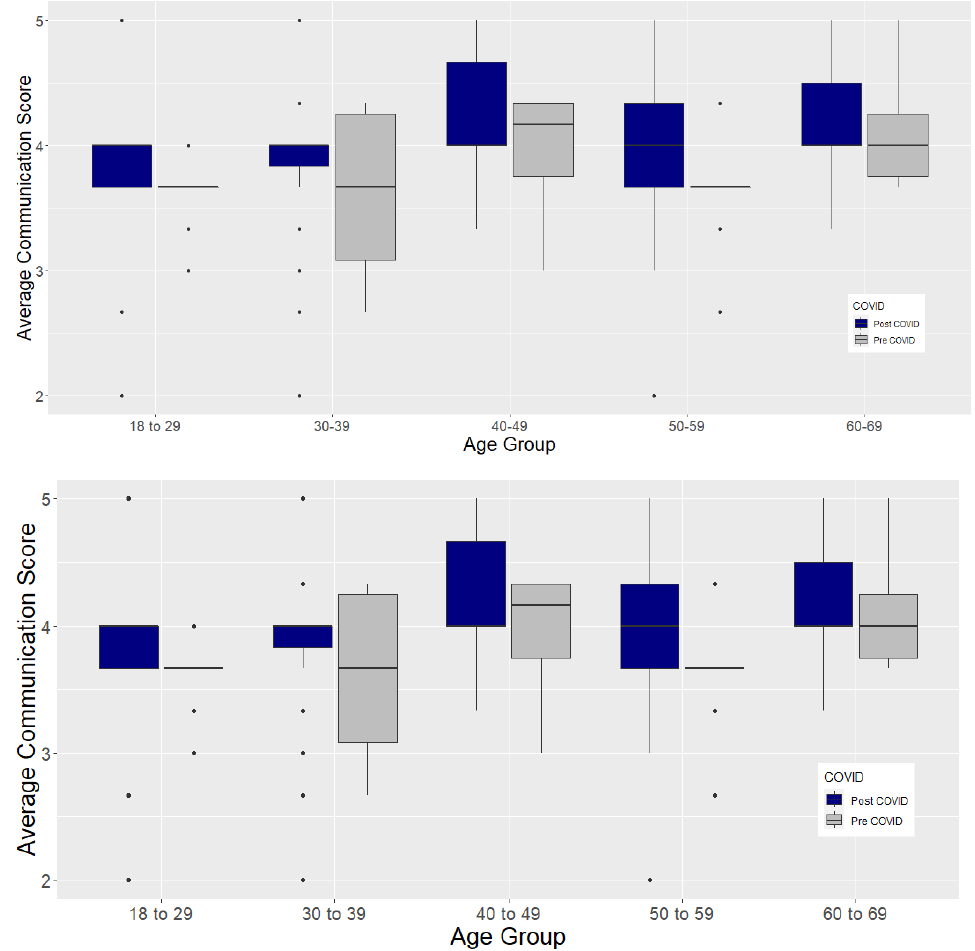
Figure 7. Communication Safety Perceptions by COVID and AGE Factors ( n = 166).